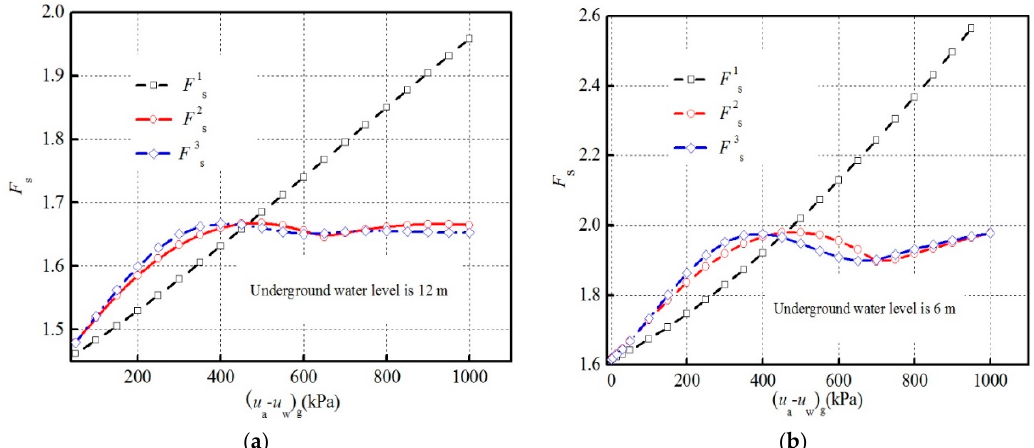
Figure 13. The influence of the distribution of ϕ b on the safety factor, ( a ) Underground water level = 6 m; ( b ) Underground water level = 12 m.